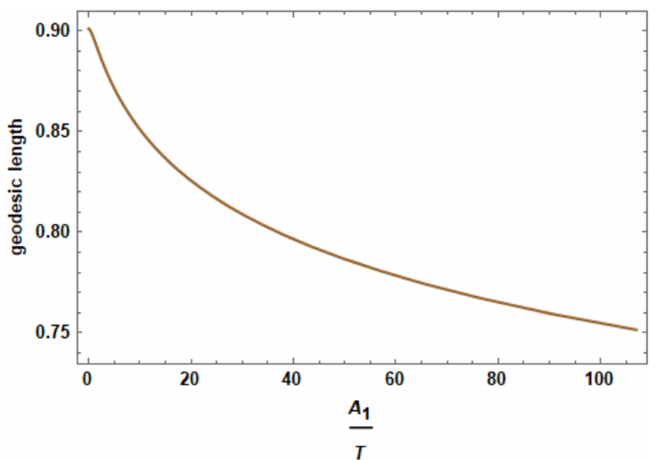
Figure 10. A representative plot of the renormalized geodesic length connecting the end points on the right and the left boundaries, where the corresponding operator is localized. In this particular case, we have set the boundary time t b = 0 for convenience. We have shown the dependence of the renormalized geodesic length as a function of the deformation parameter, a la equation (4.10) in the toy